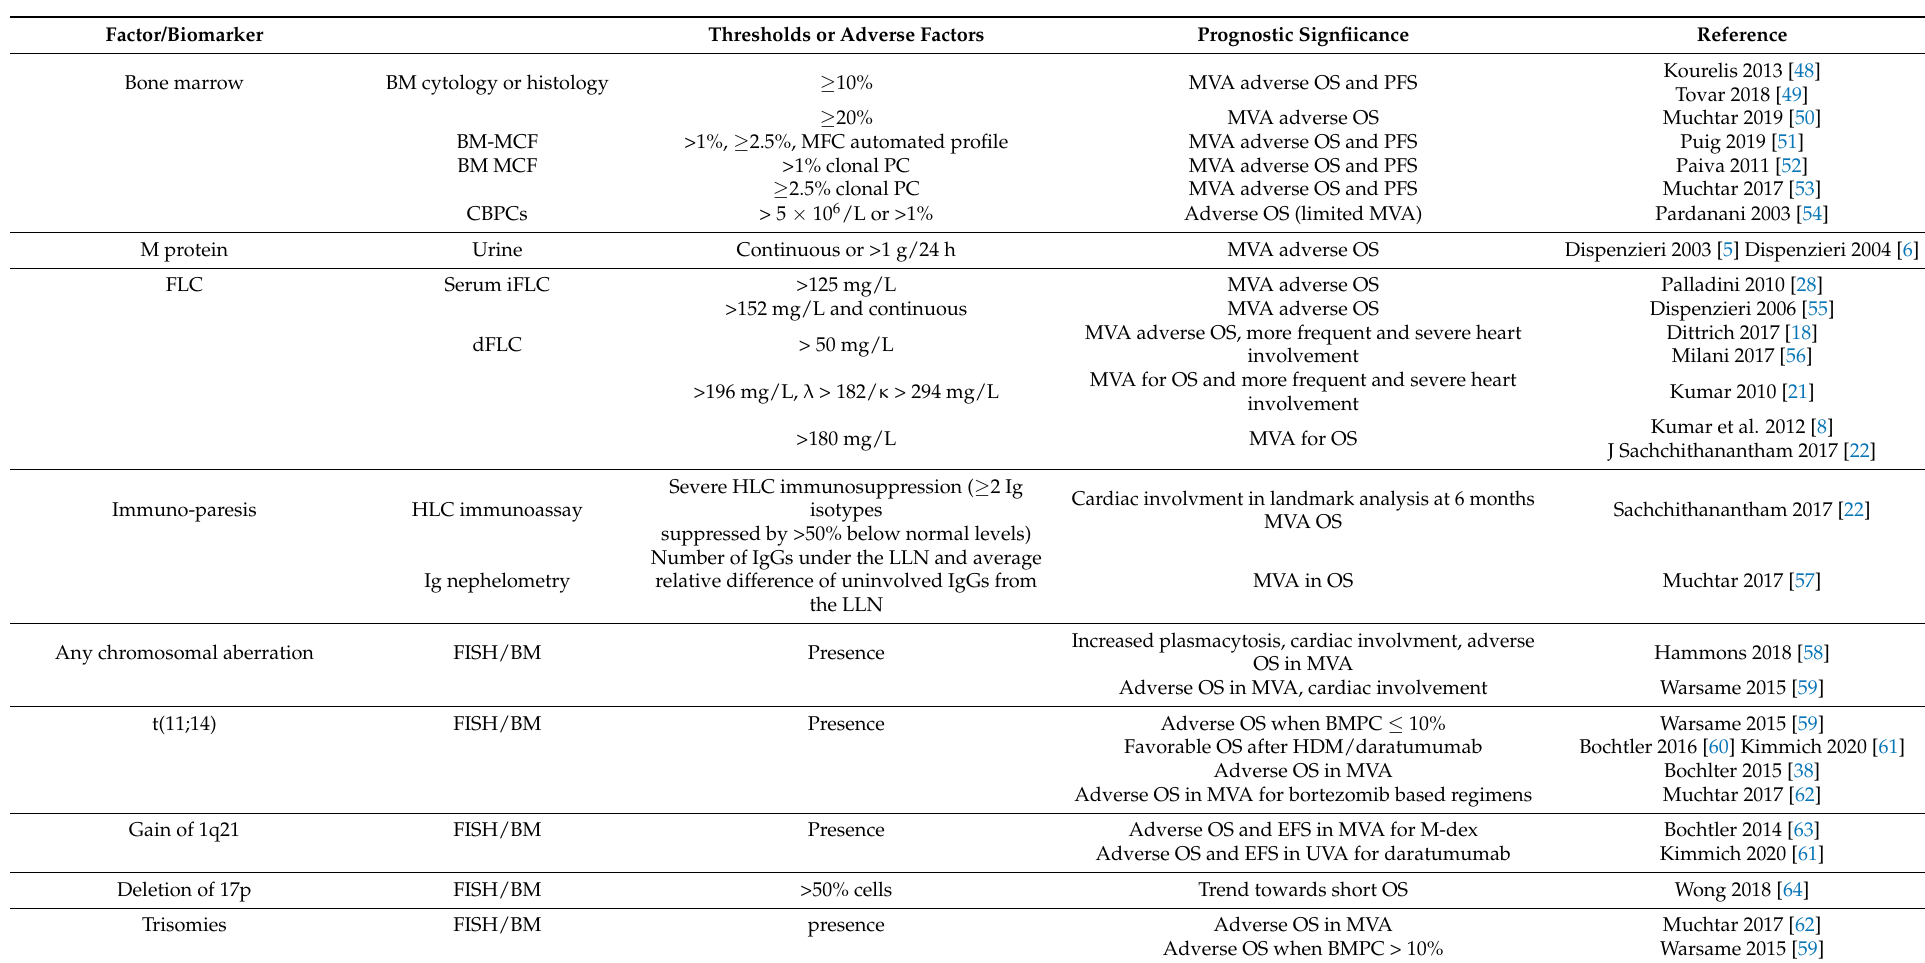
Table 3. Prognostic significance of tumor-related biomarkers. BM, bone marrow; MVA, multivariate analysis; UVA, univariate analysis; OS, overall survival; PFS, progression-free survival; EFS, event-free survival; MCF, multiparameter flow cytometry; PC, plasma cells; BMPC, bone marrow plasma cells, CBPCs, circulating blood plasma cells; M protein, monoclonal protein; FLC, free light chain; iFLC, involved free light chain; dFLC, difference between involved and uninvolved FLC; HLC, heavy light chain; LLN, lower limit of normal; FISH, fluorescence in situ hybridization; HDM, high-dose melphalan in autologous stem cell transplant; M-dex, melphalan